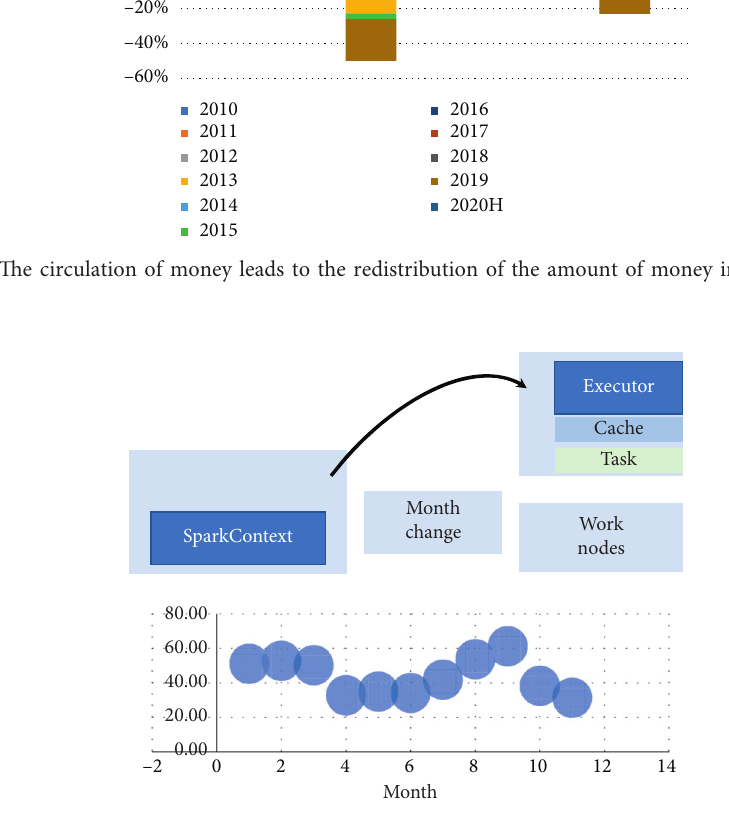
Figure 5: The impact of stocks on the money demand.